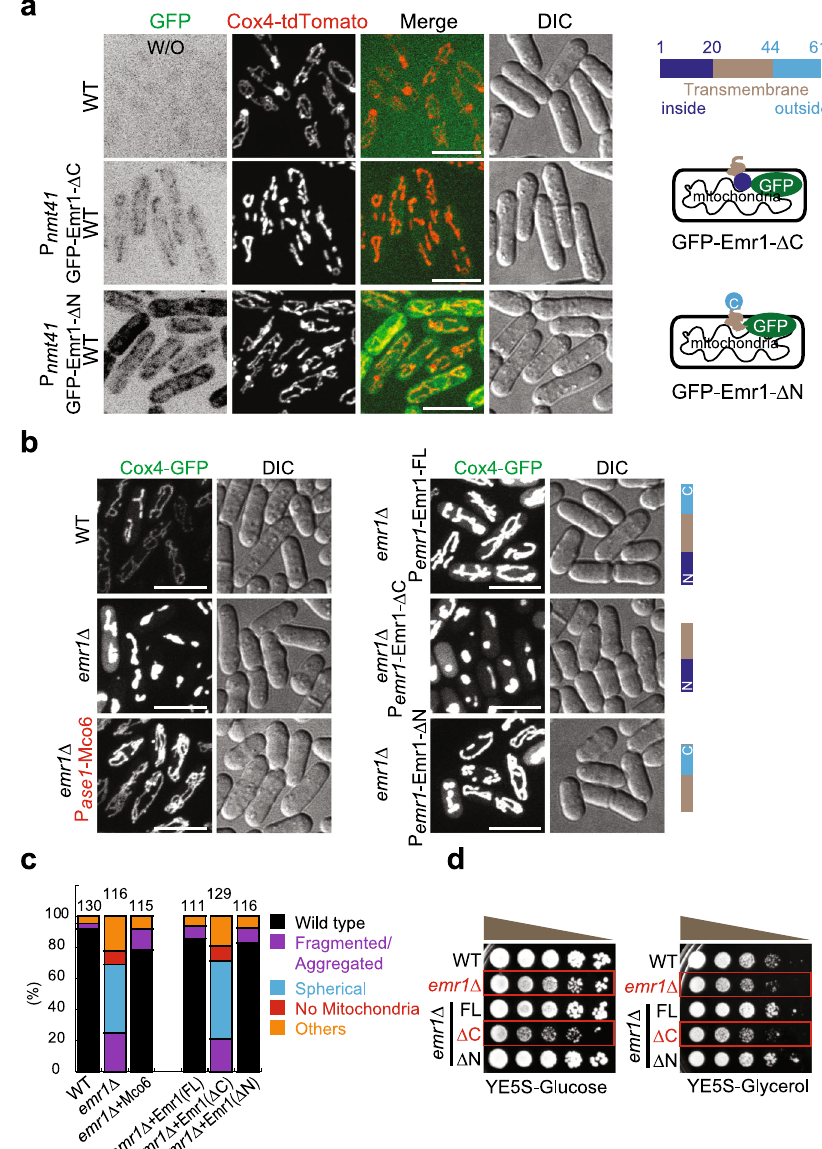
Fig. 3 The C-terminus of Emr1 is required for maintaining proper mitochondrial morphology. a Maximum projection images of WT cells expressing Cox4-tdTomato and either GFP-Emr1- Δ C or GFP-Emr1- Δ N (from the nmt41 promoter). Note that cells expressing only Cox4-tdTomato did not display signals in the GFP channel (top panel). Domain structures of GFP-Emr1- Δ C (lacking the C-terminus (a.a. 44 – 61)) and GFP-Emr1- Δ N (lacking the N- terminus (a.a. 1 – 20)) are shown on the right. Scale bar, 10 μ m. b Maximum projection images of the indicated cells expressing Cox4-GFP. Pase1-Mco6 (highlighted in red), the budding yeast homolog of Emr1 expressed from the ase1 promoter; P emr1 -Emr1-FL, full-length Emr1 expressed from its own promoter; P emr1 -Emr1- Δ C, Emr1 lacking the C-terminus (a.a. 44 – 61) expressed from its own promoter; P emr1 -Emr1- Δ N, Emr1 lacking the N-terminus (a.a. 1 – 20) expressed from its own promoter. Note that Mco6, Emr1-FL, and Emr1- Δ N, but not Emr1- Δ C, were able to rescue the mitochondrial phenotypes caused by the absence of Emr1. Scale bar, 10 μ m. c Quanti fi cation of the indicated mitochondrial phenotypes for the cells in b . Cell number observed for quanti fi cation is shown on the top of the graph. d Growth assays for the indicated cells. The indicated cells were spotted on YE5S plates containing glucose and YE5S plates containing glycerol after tenfold serial dilution. These results are in agreement with the imaging data shown in b , i.e., Emr1 Δ and Emr1- Δ C cells displayed impaired cell growth (highlighted by red